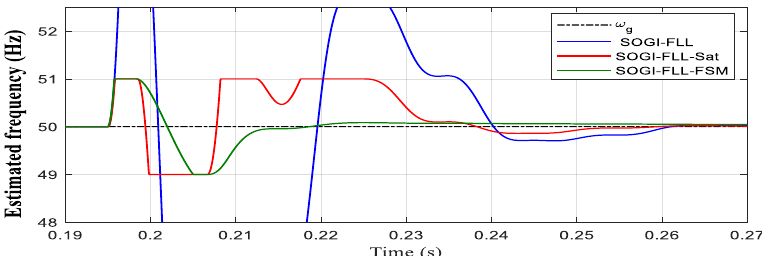
Figure 7. Example of FSM evolution during a voltage sag.